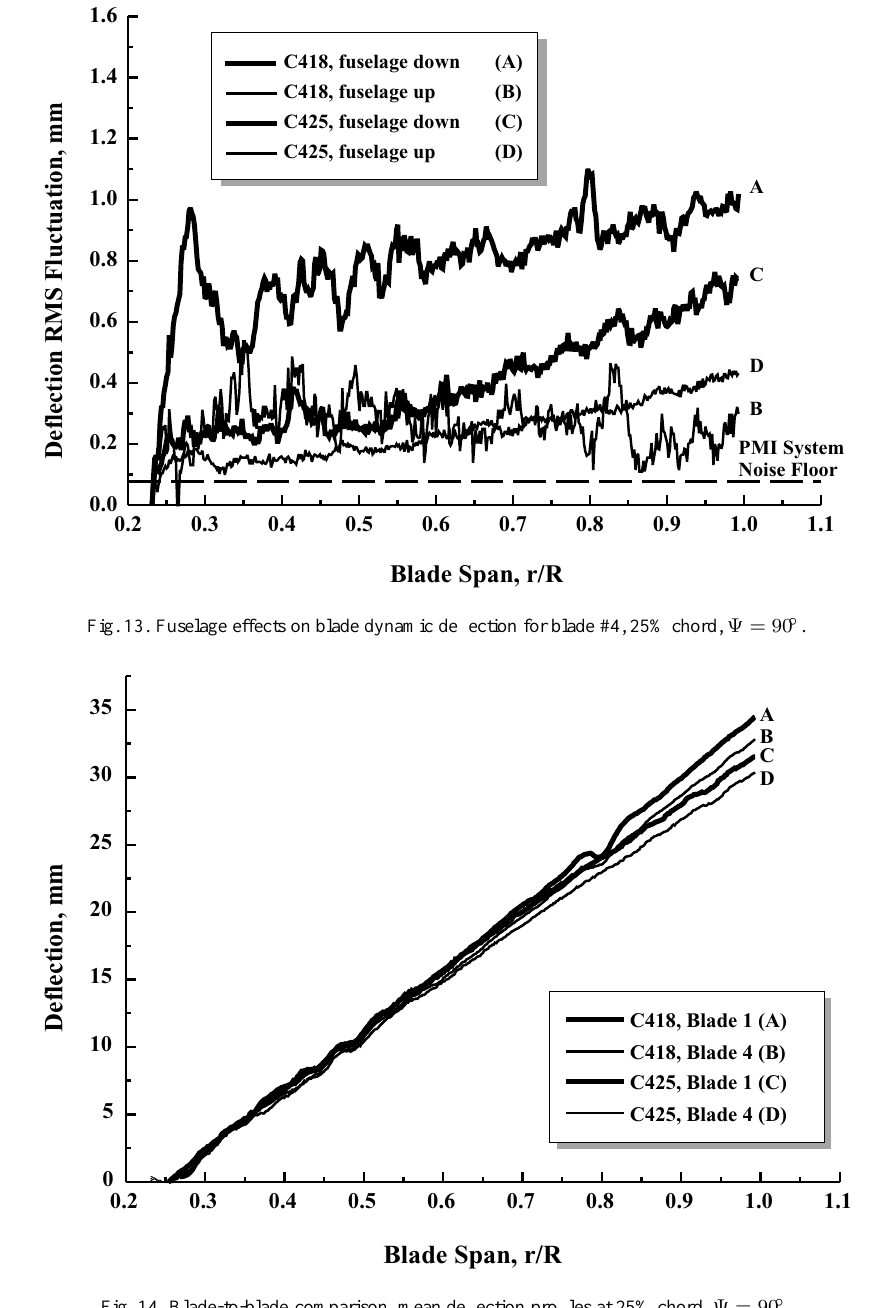
Fig. 14. Blade-to-blade comparison, mean deflection profiles at 25% chord, Ψ = 90 ◦